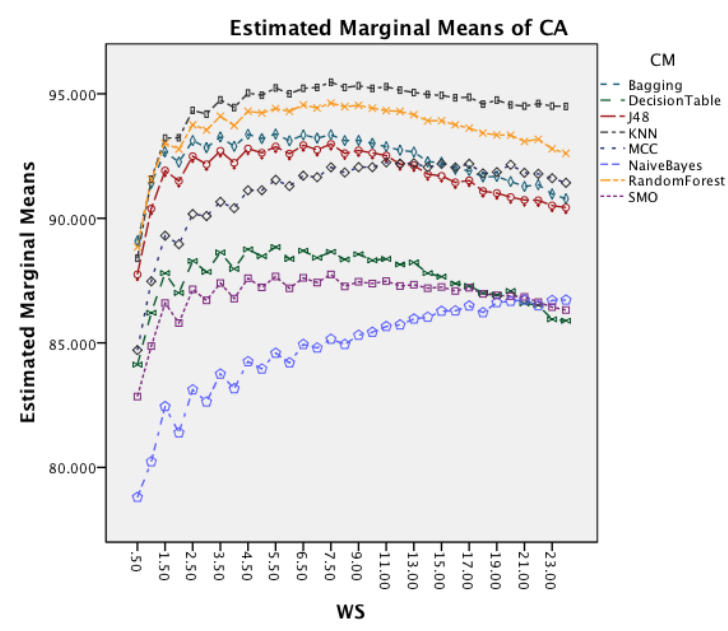
Figure 6. Two-way interaction effect for WS and CM.